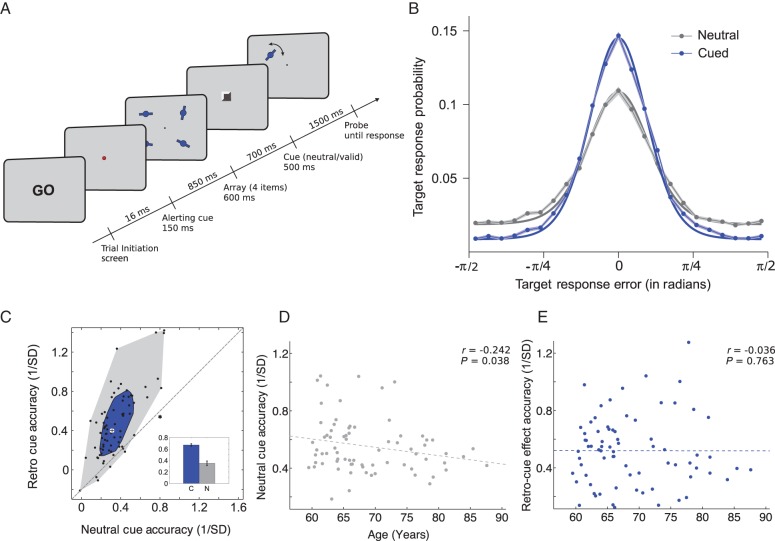
Task schematic and behavioral results for 74 participants. (A) Task schematic. Participants pressed a button to initiate each trial at the “GO” screen. Participants encoded 4 orientation stimuli into WM. After a fixed delay of 700 ms, a retro-cue appeared. In half the trials, a spatial retro-cue (100% valid) appeared, indicating the location of the item that would subsequently be probed. In the other trials, a neutral retro-cue provided no predictive information about the location to be probed. After another fixed delay of 1500 ms, a randomly oriented probe bar appeared in one of the quadrants. Participants indicated the orientation of the item at that location in the memory array by rotating the bar and confirmed with a button press. After responding, the correct orientation of the memory-array item was overlaid as feedback (not shown here). (B) Response error distributions centered on the target for spatial and neutral retro-cue conditions. The mean error is plotted at each bin and connected by the lines for the spatial (blue) and neutral (gray) retro-cue condition and the shading shows the SEM. The smooth lines show the model fit (weighted mixture of the von Mises and uniform distribution). x-Axis shows response error in radians, and y-axis is the response error probability. (C) Scatter and bag plot and bar plot showing the effect of the spatial retro-cue on WM behavioral measures. The small bar-plot inset shows WM accuracy for the spatial (blue) and neutral (gray) cue conditions (***P < 0.0001). For the scatter and bag plot, dots represent individual participants, x-axis is accuracy on neutral retro-cue conditions and the y-axis is accuracy on spatial retro-cue conditions. Dots above the diagonal represent participants who exhibited an increase in WM accuracy in the retro-cue conditions relative to the neutral-cue conditions and dots below the diagonal represent a decrease in accuracy in the retro-cue relative to neutral-cue conditions. The inner blue bag includes 50% of the data with the largest depth, the outer gray polygon contains all other nonoutlier data points, and the Xs outside of the shaded areas represent outliers. The cross at the center of the bag plot represents the center of mass of the bivariate distribution of empirical data (Rousseeuw et al. 1999). (D,E) Age was negatively correlated with accuracy in the neutral-cue condition (D) but not with retro-cue benefit (E). Correlation values are Spearman's rank correlation coefficients.